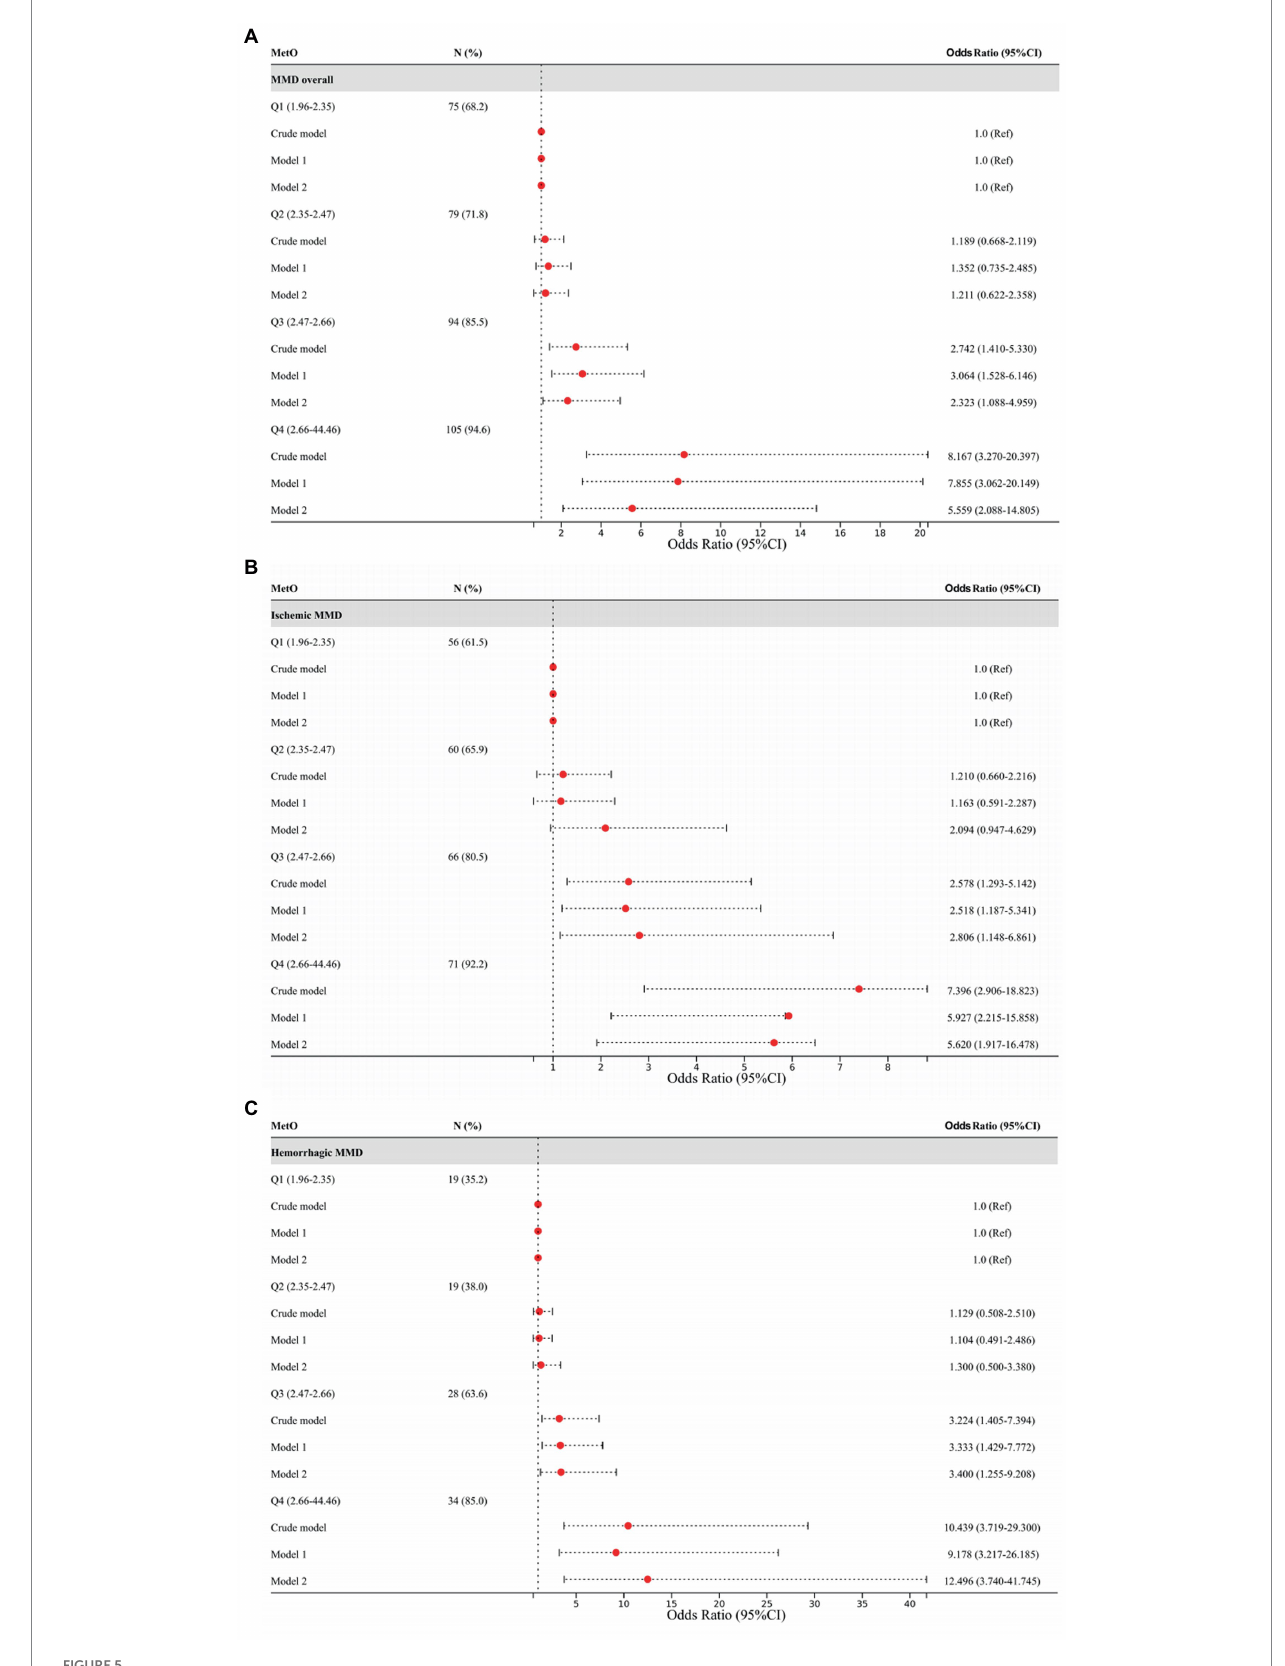
FIGURE 5 Association between different quartiles of MetO and the risk of MMD and its subtypes. (A) MMD overall; (B) Ischemic-type; (C)